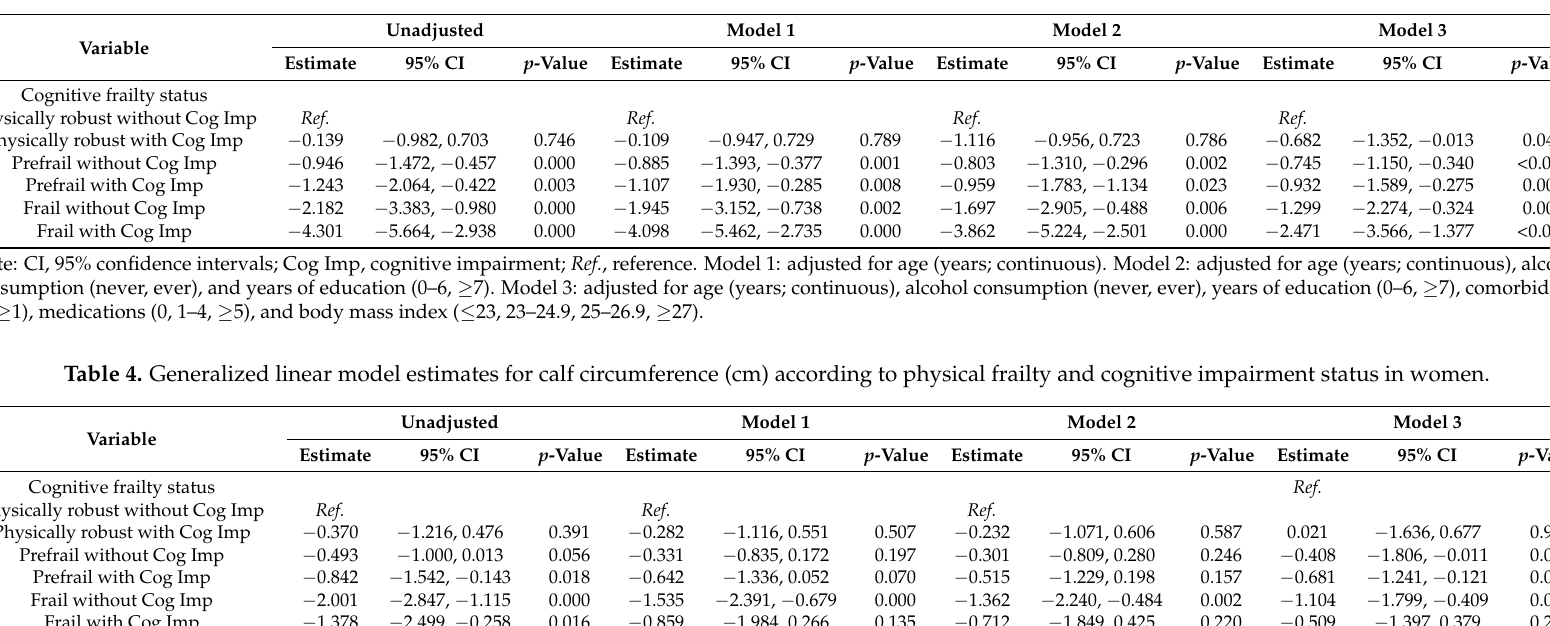
Table 3. Generalized linear model estimates for calf circumference (cm) according to physical frailty and cognitive impairment status in men. Unadjusted Model 1 Model 2 Model 3 Variable Estimate 95% CI p -Value Estimate 95% CI p -Value Estimate 95% CI p -Value Estimate 95% CI p -Value Cognitive frailty status Physically robust without Cog Imp Ref. Ref.